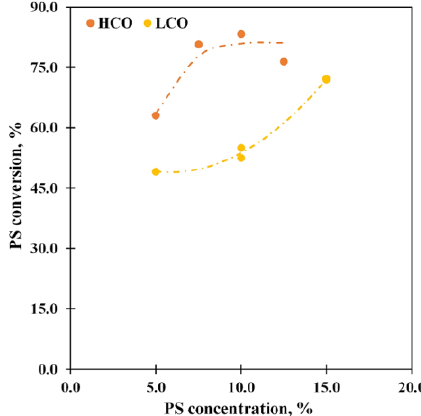
Polymers 2023 , 15 , x FOR PEER REVIEW Figure 7. The PS conversion vs. the PS concentration at 550 °C and WHSV 85 h − 1 . Figure 7. The PS conversion vs. the PS concentration at 550